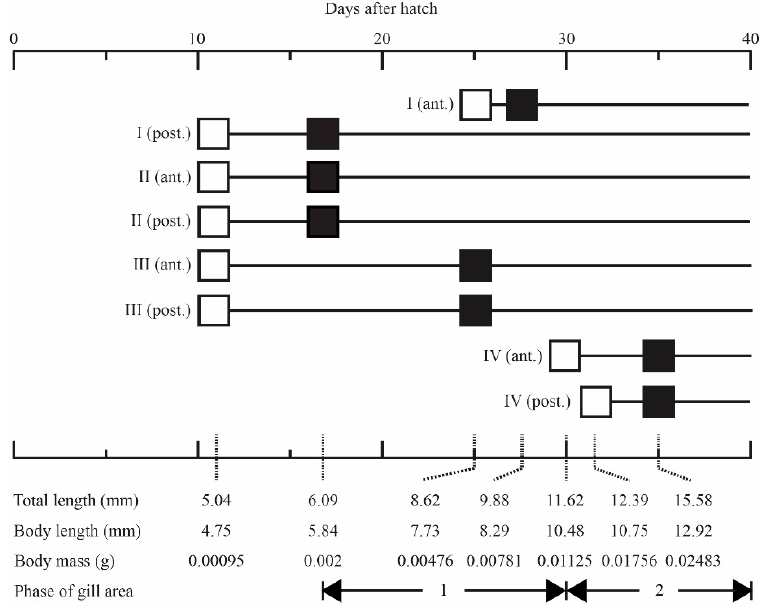
Figure 1. Schematic diagram of gill development in Japanese flounder. Square symbols indicate the first appearance of gill filaments (open black squares) and secondary lamellae (closed black squares) on the anterior (ant.) and posterior (post.) hemibranches of the first (I) to fourth (IV) gill